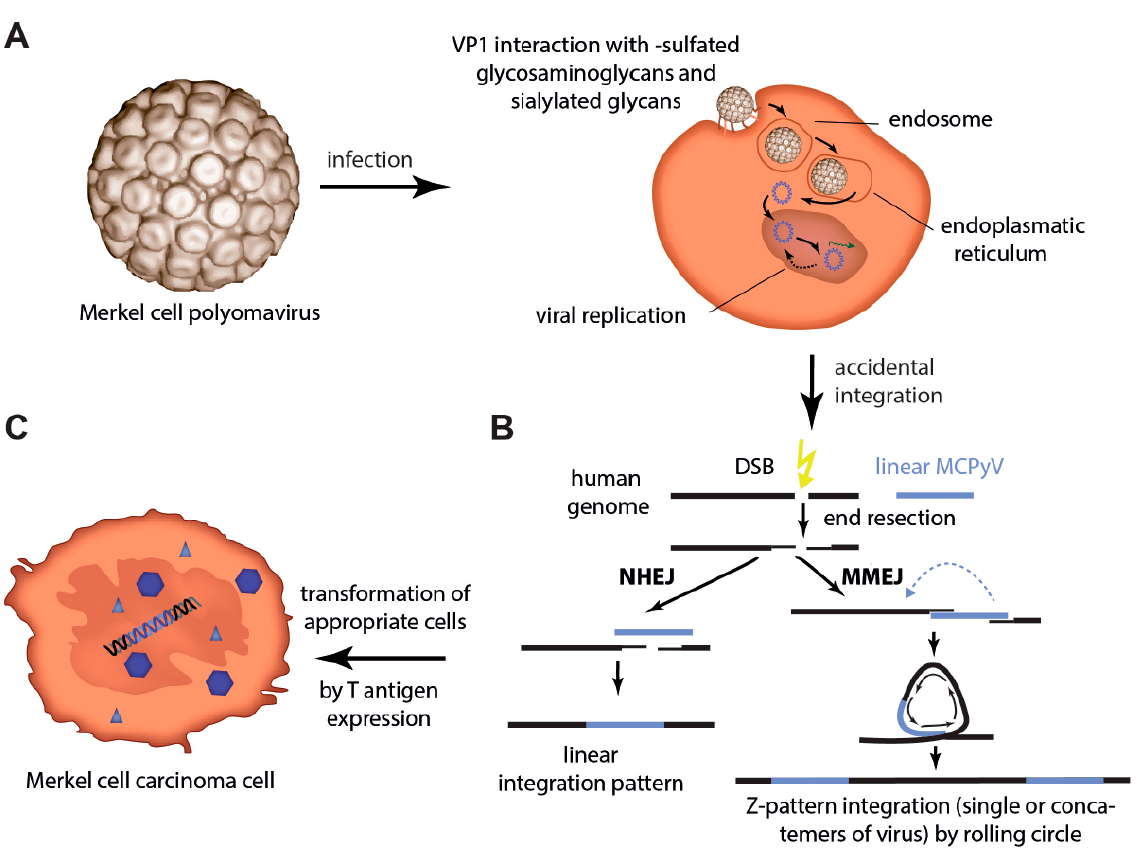
Figure 1. Merkel cell polyomavirus infection and integration. ( A ) After binding of VP1 to sulfated glycosaminoglycans for initial attachment followed by secondary interaction with sialylated glycans, MCPyV enters cells via caveolar/lipid raft-mediated endocytosis. Internalized in small endocytic pits the virus is routed via endosomes to the endoplasmic reticulum probably necessary for uncoating and translocation into the cytosol. Nuclear entry requires mitotic activity of the host cells [28]. ( B ) Integration into the host cell genome is not part of the polyomavirus life cycle. However, in a random genetic accident integration of genomic sequences of MCPyV can occur. Errors during the process of the bidirectional virus replication allow rolling circle amplification or double-strand breaks (DSB) and recombination to cause linear defective viral genomes, which may be present as concatemers. After DSB in the host genome, those linear virus genomes can be ligated into the human genome by either non-homologous end joining (NHEJ) (linear integration pattern) or microhomology-mediated end joining (MMEJ). The latter will result in amplification of host sequence around the integration site (Z-pattern integration) [31,32]. ( C ) When integration of the virus occurs in an MCC progenitor cell, T antigen expression will initiate its transformation.